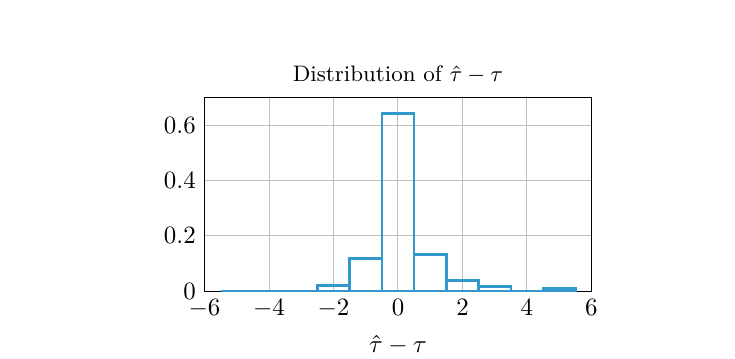
Figure 3: Histogram representing the empirical distribution of the difference between the detected change points ˆ τ and the corresponding first error locations τ (excluding false positive detections), computed over 2,000 H-CPA attacks on simulated data (see Section